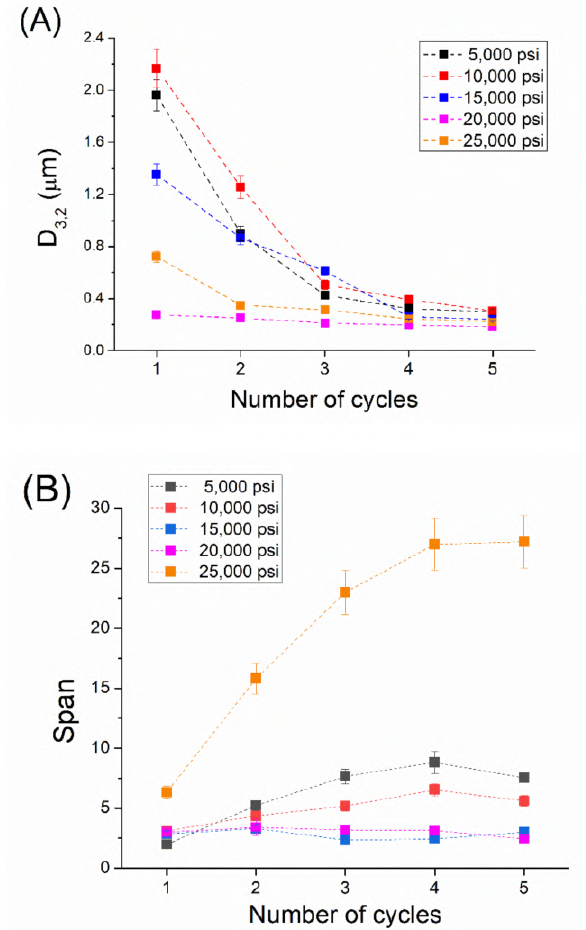
Figure 2. ( A ). Sauter mean diameter for the emulsions developed by microfluidization as a function of the number of cycles and the homogenization pressure. ( B ). Span values for the emulsions developed by microfluidization as a function of the number of cycles and the homogenization pressure.